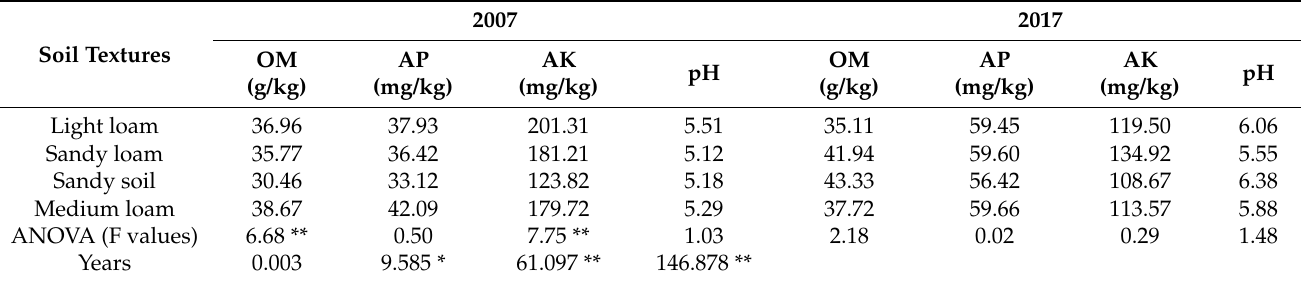
Table 6. Difference significance tests of soil properties between 2 crop years (2007an 2017) and 4 soil texture.